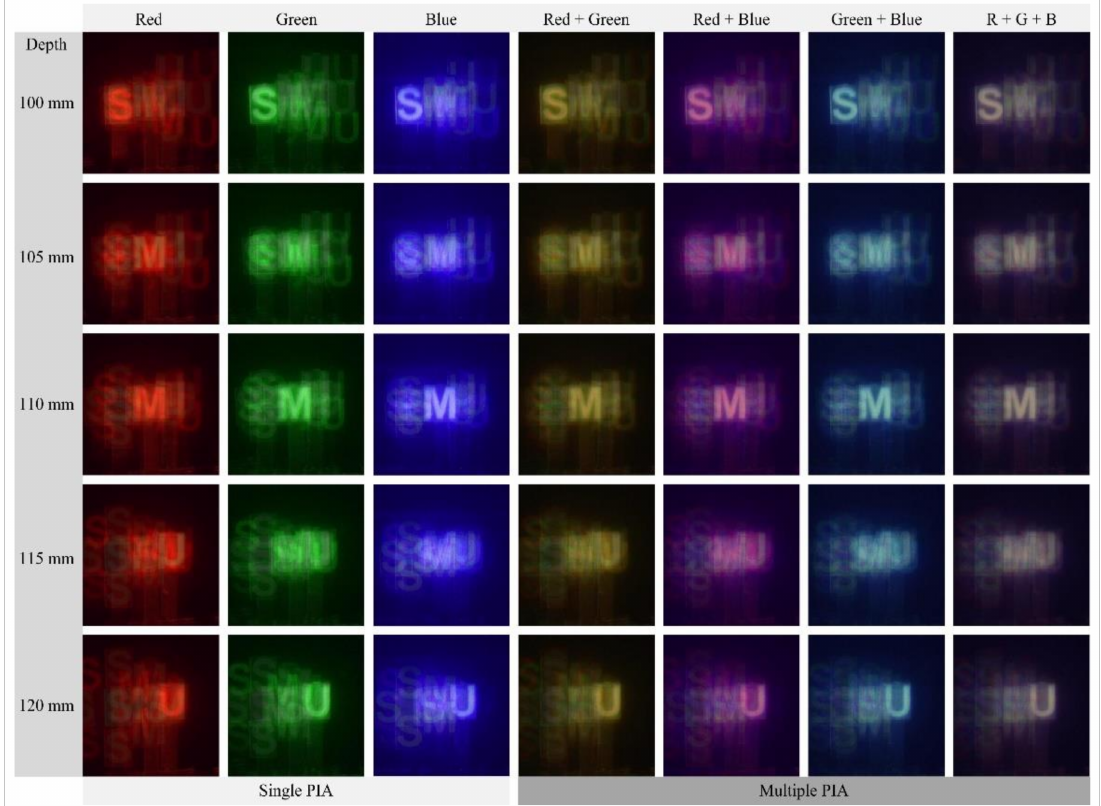
Figure 10. 3-D reconstructed images for the PIAs in Figure 9a. Each image of three columns’ left is reconstructed from a single PIA. Each image of four columns’ right is reconstructed from multiple PIAs. The row indicates the depth of each image with a step of 5